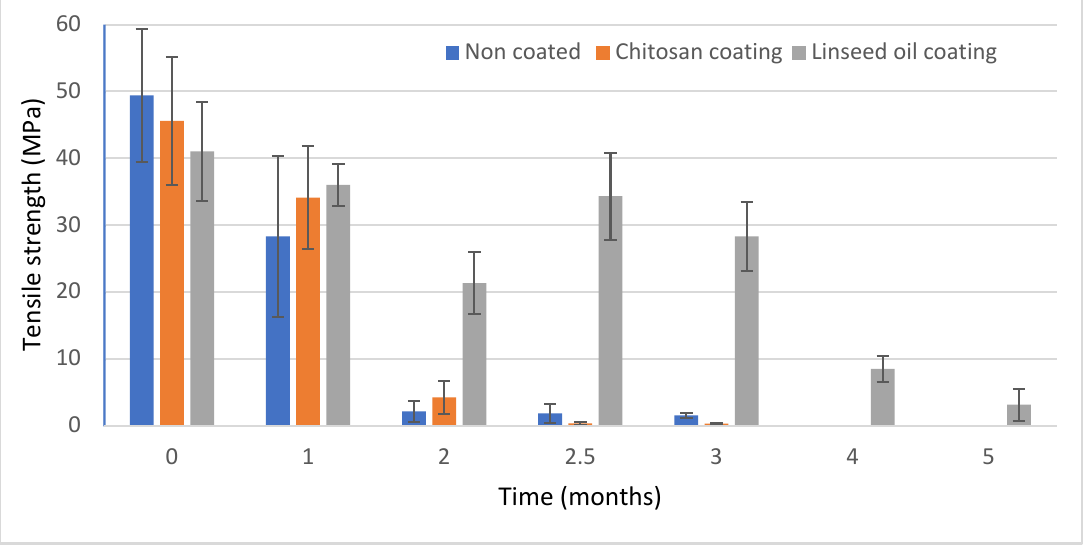
Figure 7. Tensile strength of non-coated and coated yarns as a function of the duration of time the yarns have been in the ground.